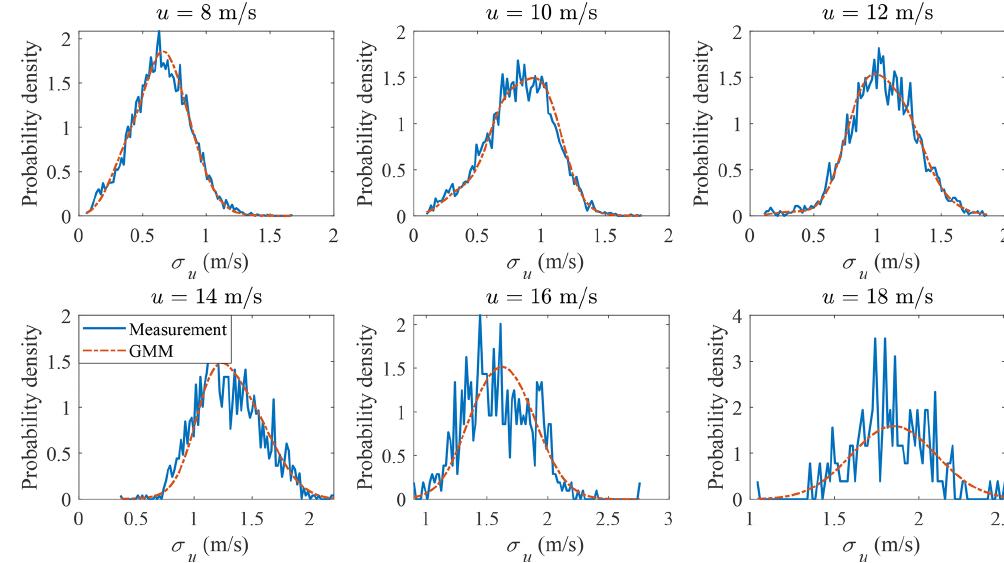
Figure 18. GMM probability distribution of σ u conditional on u for the onshore sector.